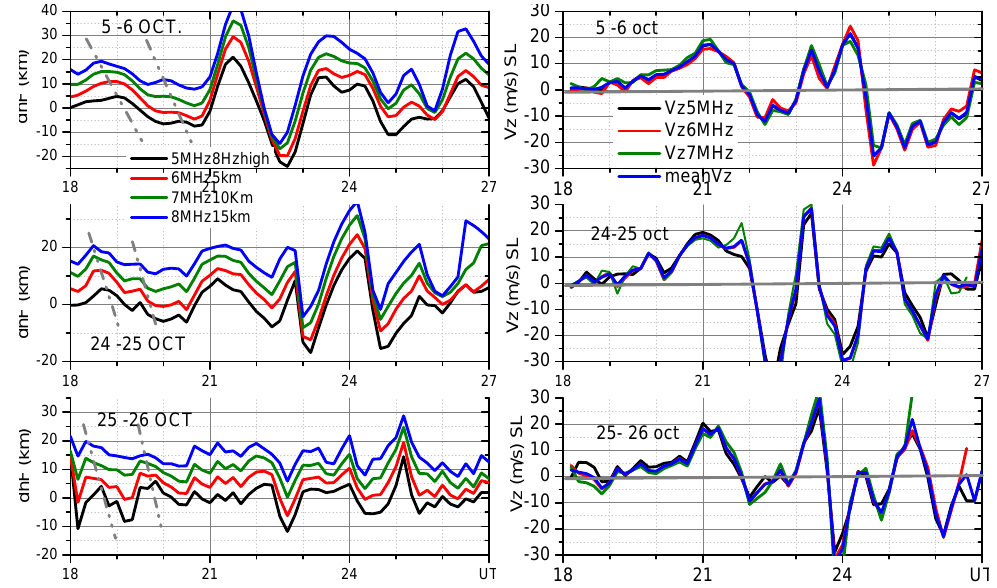
Fig. 1. In the left panels are shown perturbations in F layer true heights at frequencies: 5, 6, 7 and 8MHz, band-pass filtered between Fig. 1 periods 20min and 3h. The results are shown for three days. The plots are displaced cumulatively by 5km at each frequency, and are in UT (=LT+3h). We can clearly identify the presence of gravity waves from their downward phase propagation during the period immediately before the sunset (21:00UT/18:00LT). In the right panels are shown for the same three days the vertical drifts calculated as d(h F ) /dt. The peak amplitude of the evening prereversal drift enhancement occurs near 21:00UT/18:00LT. Much of the drifts at later hours are influenced by range spreading due to ESF